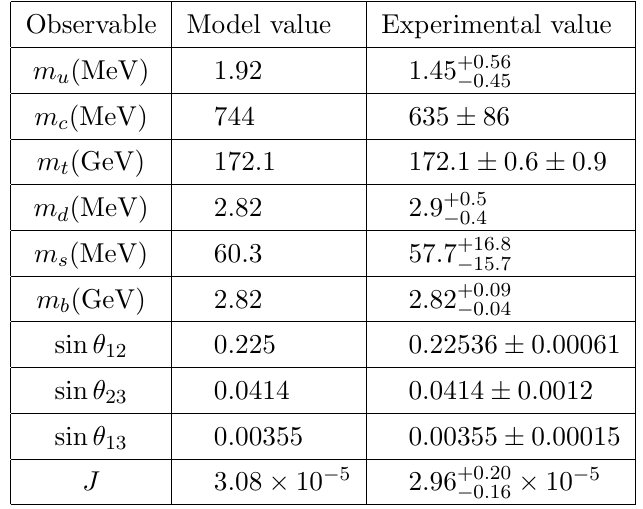
Table 6 . Model and experimental values of the quark masses and CKM